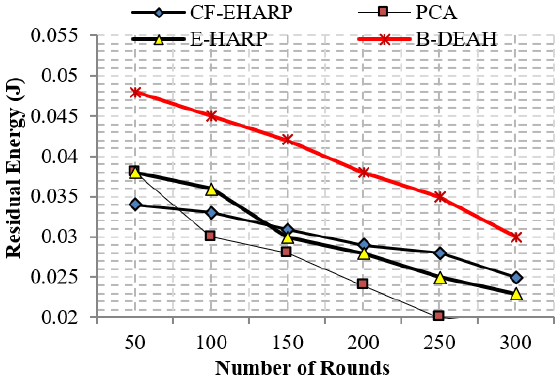
Figure 15. Residual energy vs. simulation rounds (periodic